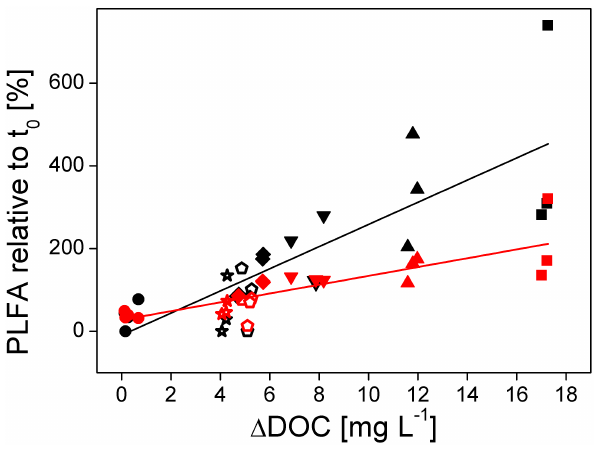
Fig. 4. Relative changes in the total phospholipid fatty acids (PLFA; in red) and i + a 15 : 0 PLFA (in black) plotted against consumed DOC ( 1 DOC inmg CL − 1 ) from all controls, single incubations and treatments. Different symbols represent the different controls and treatments: circle, control without DOC addition; open star, sin- gle DOC phyto ; open pentagon, single DOC leaf ; rhombus, 1; triangle down, 2; triangle up, 3; and square, 4. The percentages refer to the relative changes in concentrations from the beginning ( t 0 ) to the end of the experiment ( t 12 ) . The red line is the linear fit for total PLFA ( y = 27.5 + 10.7 times and R 2 = 0 . 69) and the black line for i + a 15 : 0 PLFA ( y =− 9.5 + 26.8 times and R 2 = 0 . 65).